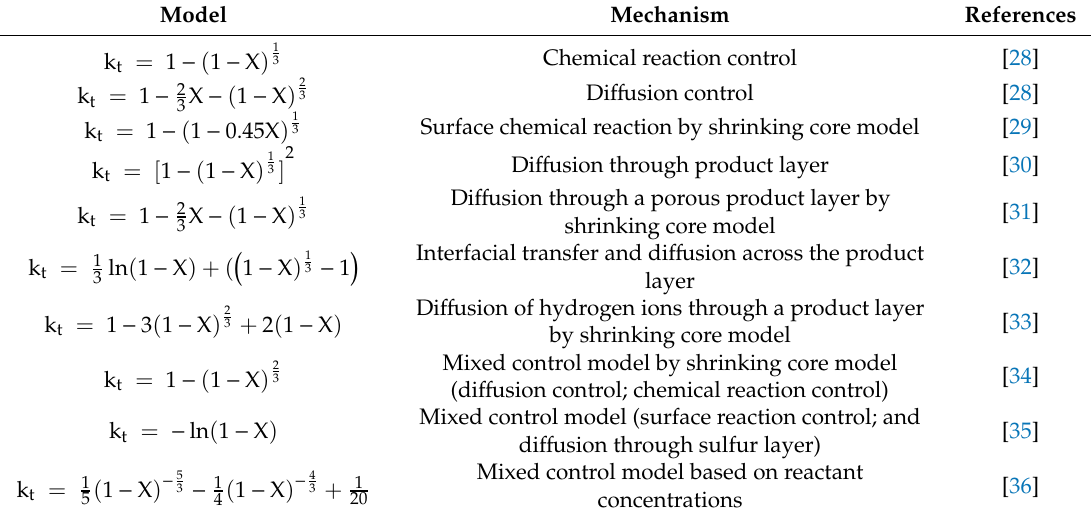
Table 3. Kinetics models suggested for leaching process (X = fraction reacted, K t = kinetic constant, t =